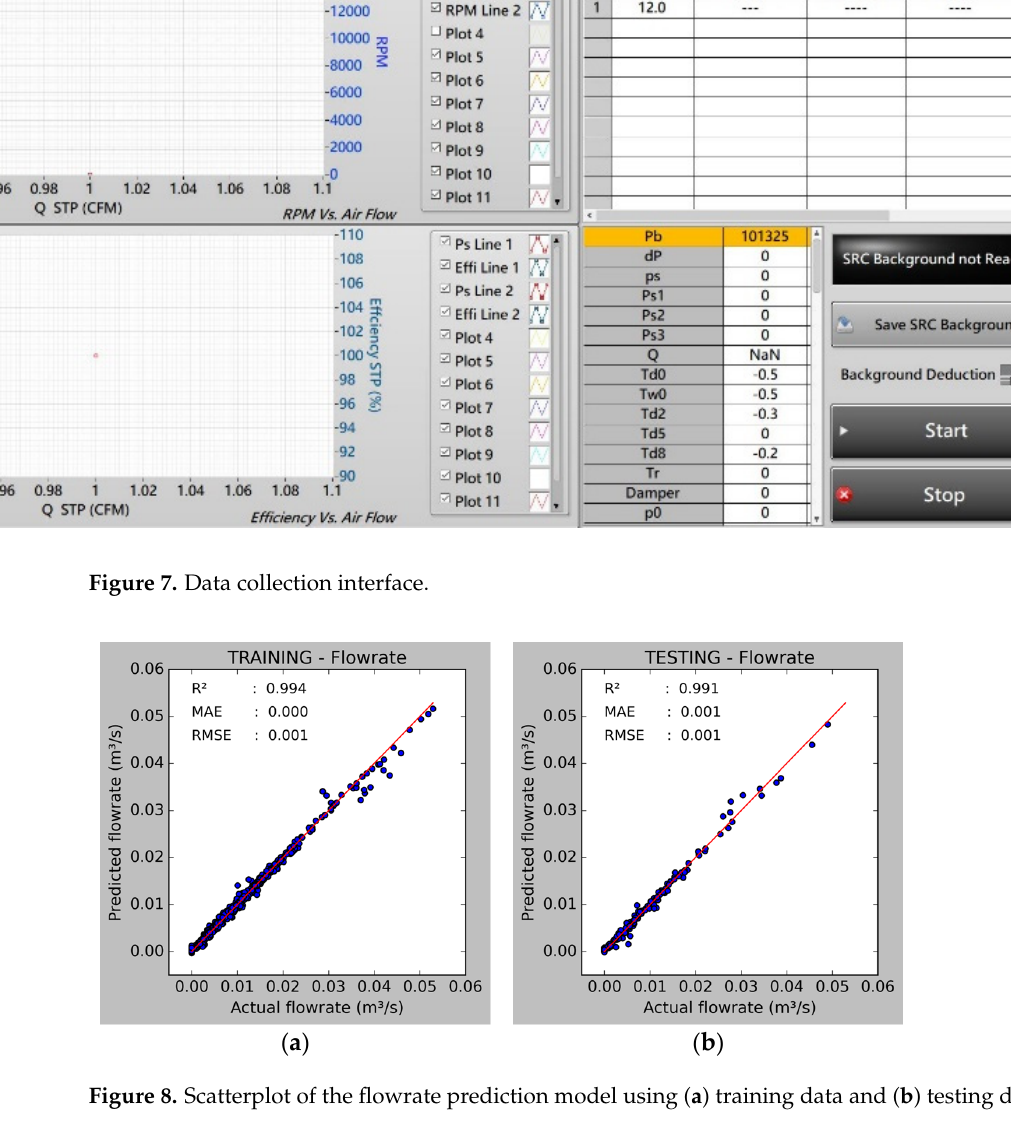
Figure 7. Data collection interface.